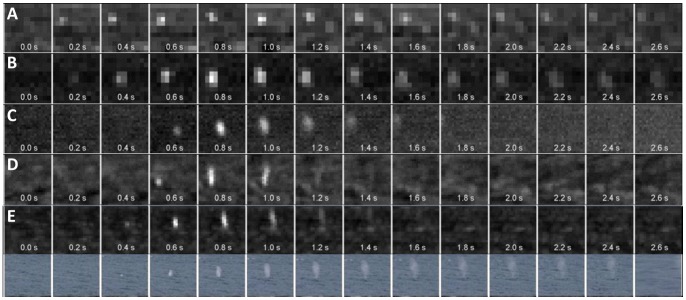
Night-time thermographic video snippets (at 0.2 s resolution) of whale blows:A) 24.03.2012 00:07; 61.11°S 56.36°W; Twater = 1.3°C; Tair = −1.7°C; r = 3608 m; B) 28.03.2012 03:27; 61.88°S 60.29°W; Twater = 1.4°C; Tair = 2.3°C; r = 3608 m; C) 29.12.2011 01:06; 56.49°S 00.00°E; Twater = −0.8°C; Tair = −0.5°C; r = 1116 m; D) 01.01.2012 02:38; 43.96°S 07.44°E; Twater = 8.8°C; Tair = 8.7°C; r = 879 m; Figure 2E: Day-time thermographic (top) and visual (bottom) video snippets of an automatically detected whale blow: 28.12.2011 14:41; 58.65°S 0.02°E; Twater = −1.5°C; Tair = −0.6°C; r = 1072 m;